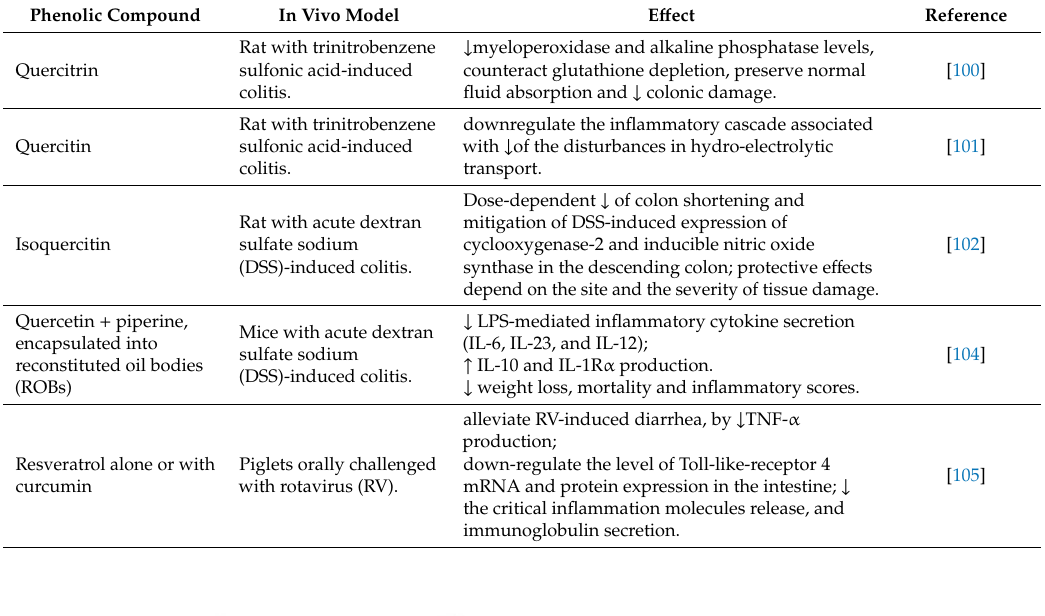
Table 3. Clinicopathological and histological e ff ects of polyphenols in di ff erent in vivo models. ↑ indicates an increase; ↓ indicates a decrease.